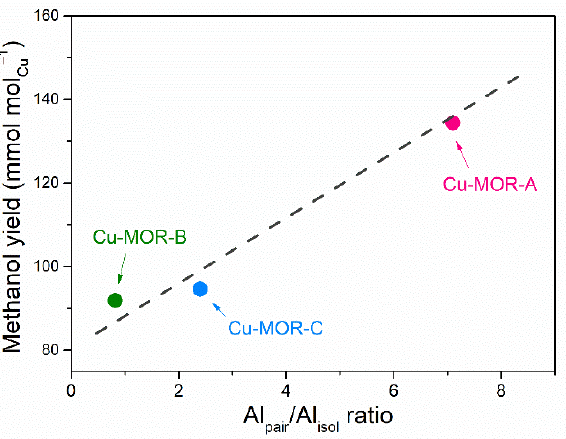
Figure 3. Correlation between Al pair /Al isol ratios for the three Cu-MOR samples and their corresponding methanol yields at the threshold Cu loading. The dashed line represents a trend line.